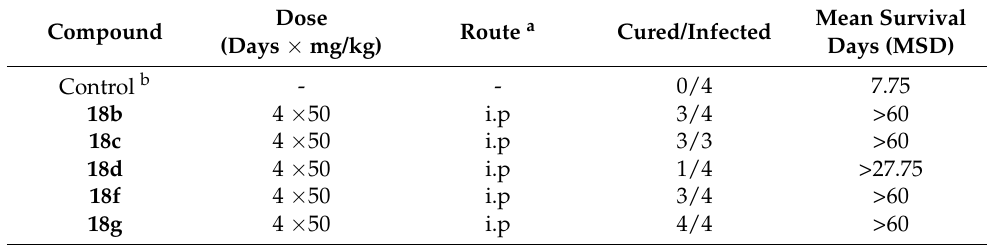
Table 3. Efficacy of selected compounds in the treatment of an acute mouse model of HAT (STIB 900). Dose Compound (Days × mg/kg)